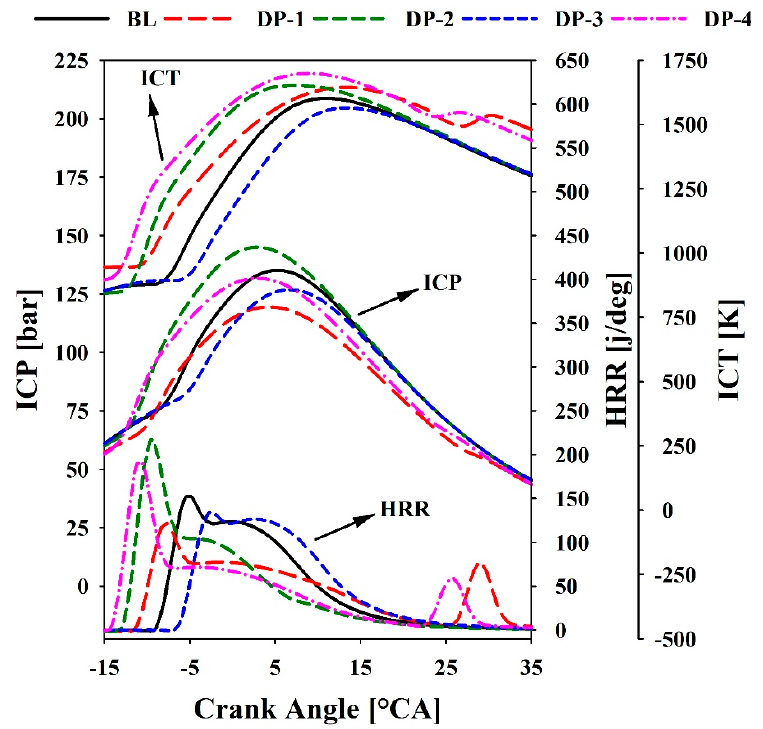
Figure 18. ICP, ICT and HRR patterns for the selected optimum design points .